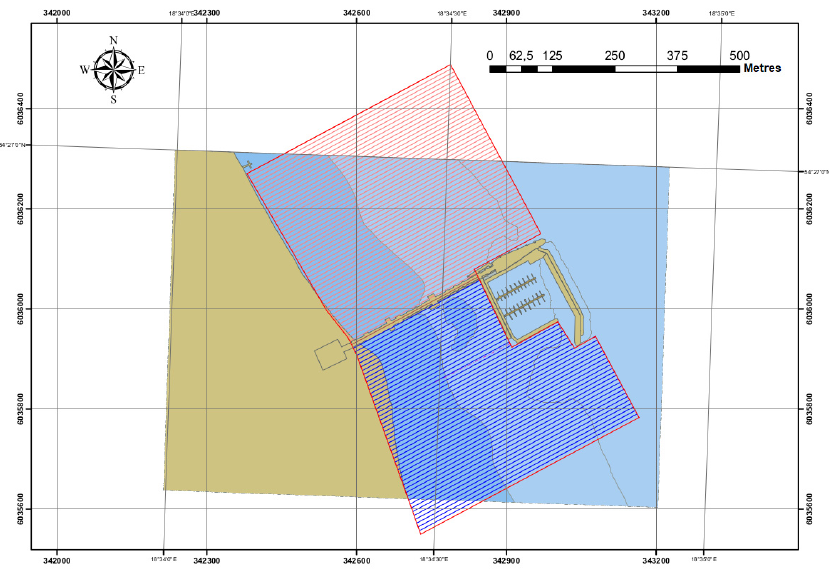
Figure 10. Planned sounding profiles for the hydrographic vessel.